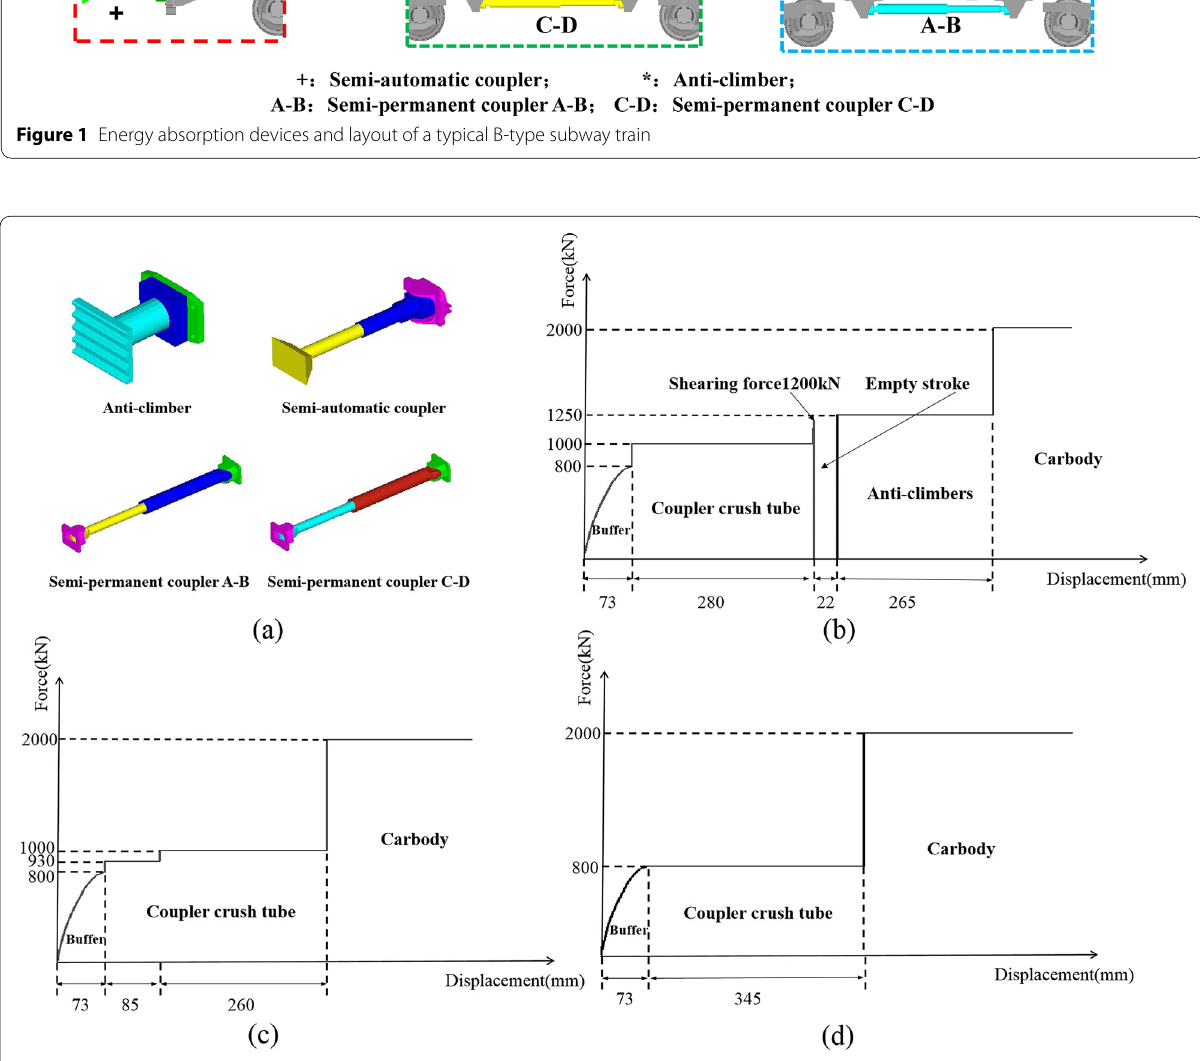
Figure 2 Energy-absorbing structure and mechanical characteristics: a energy-absorption devices, b semi-automatic coupler and anti-climber devices, c semi-permanent coupler A-B, and d semi-permanent coupler